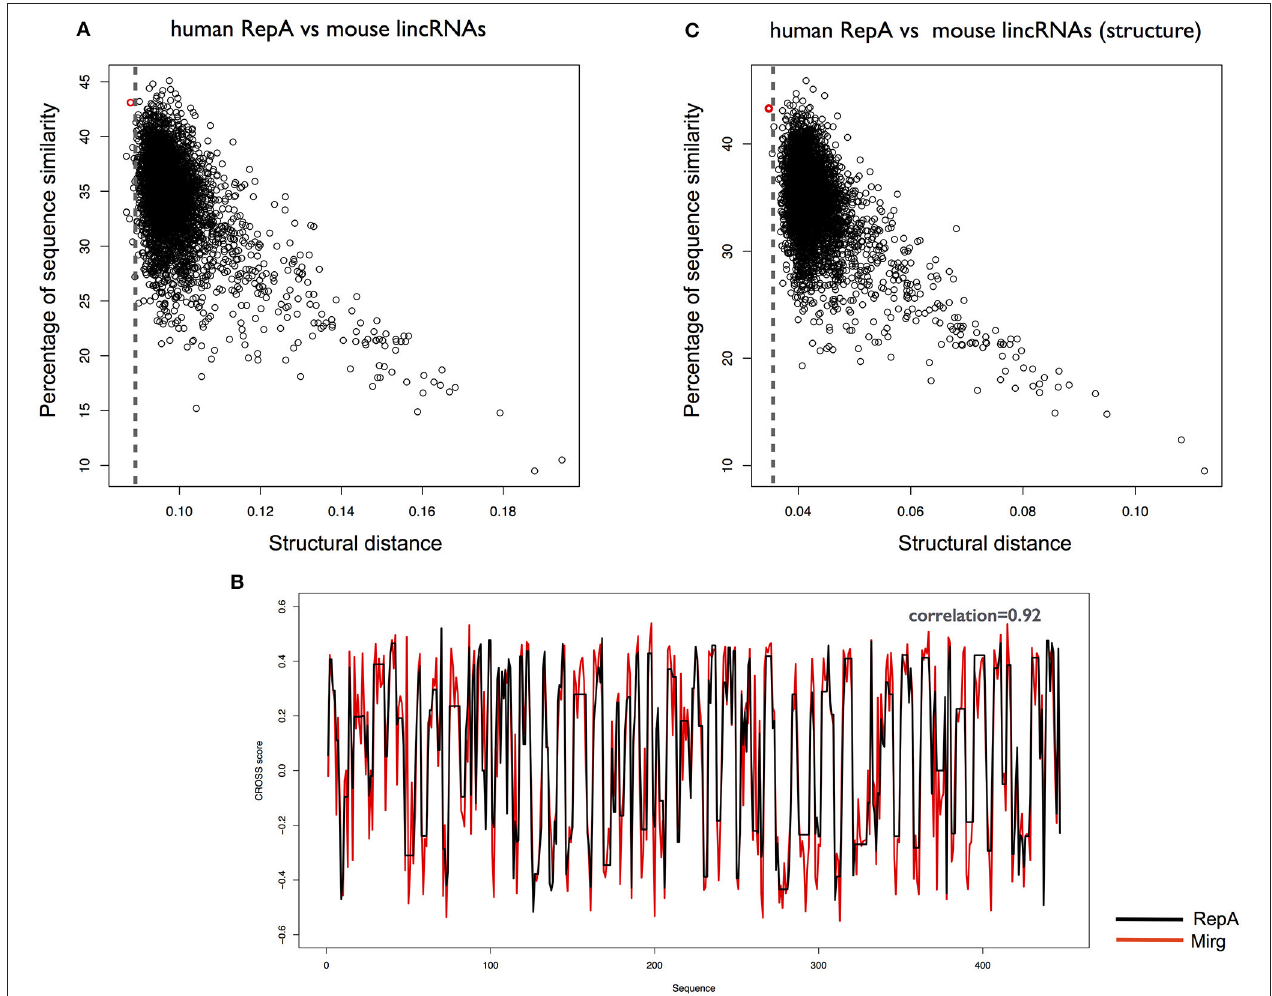
FIGURE 4 | Structural similarities between human and mouse XIST RepA. (A) Structural similarities of human RepA against all mouse lincRNAs. The distance was calculated using CROSSalign ( OBE-DTW ) and plotted against sequence similarity. Human RepA is not the best match (5th best hit; colored in red). (B) Structural similarities of human RepA against all mouse lincRNAs using double-stranded nucleotides (nucleotide with CROSS score < 0 are set to 0). Human RepA is identified as the best match (colored in red), which highlights the importance of the structural content for the regulatory domains of the lncRNAs. (C) Secondary structure profile of human RepA, obtained as optimal path with OBE-DTW , compared with the best match in mouse lincRNAs ( Mirg ; ENSMUSG00000097391). The two secondary structure profiles show a strong a correlation